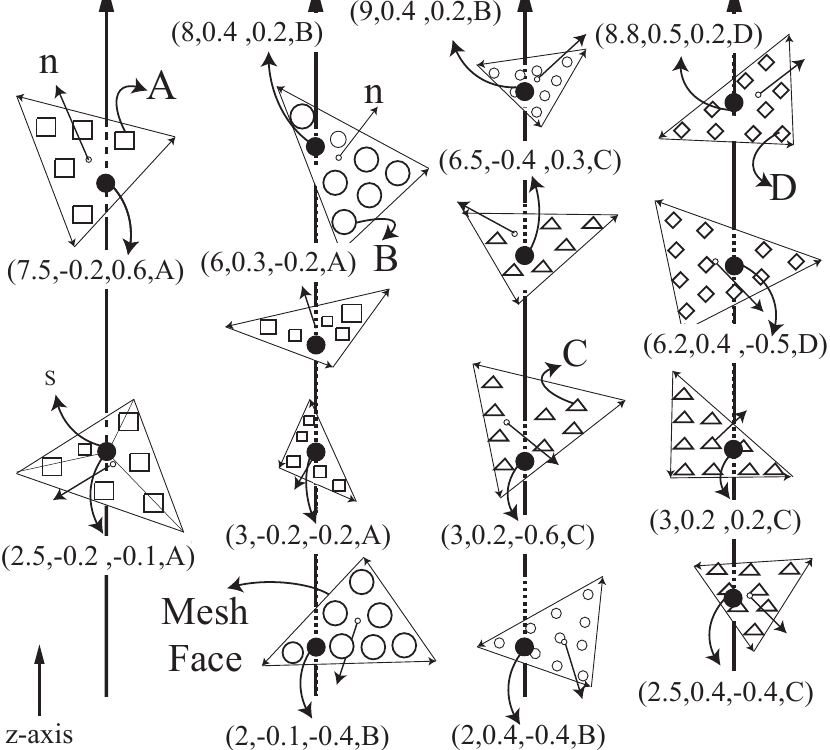
Figure 5. Ray tracing process to obtain the LDMI sample